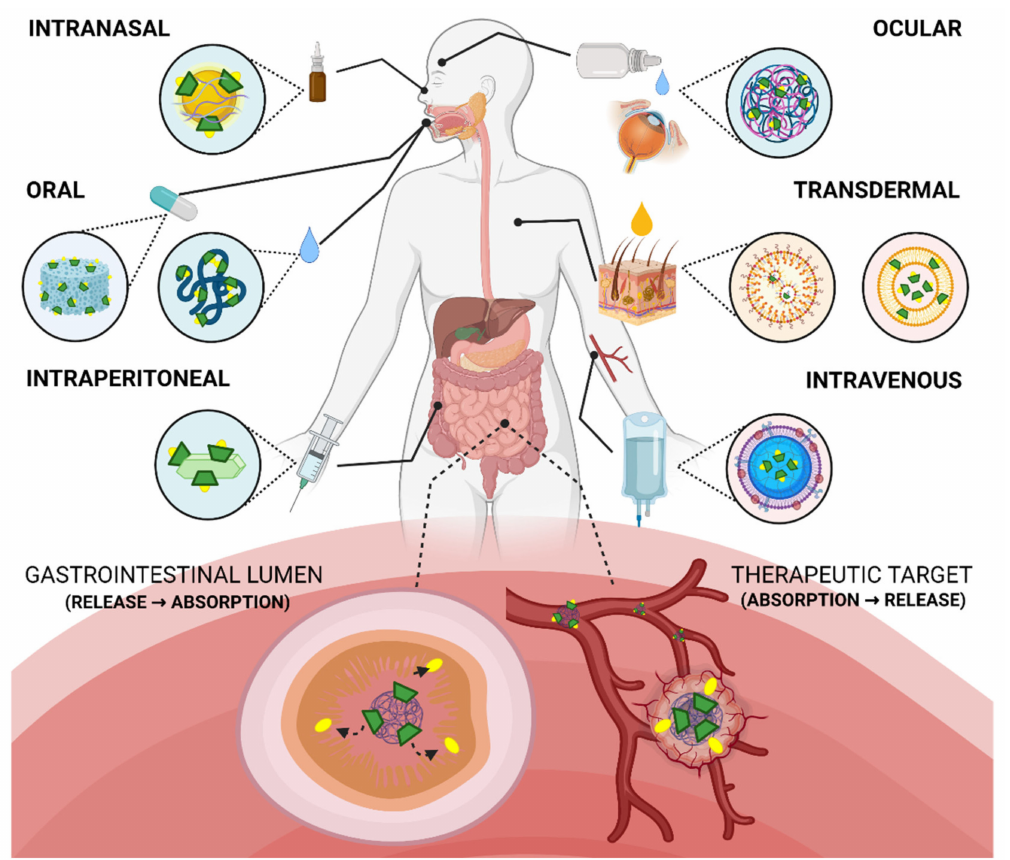
Figure 5. Different routes of administration where CD-modified nanomaterials have been shown to increase bioavailability. Created with